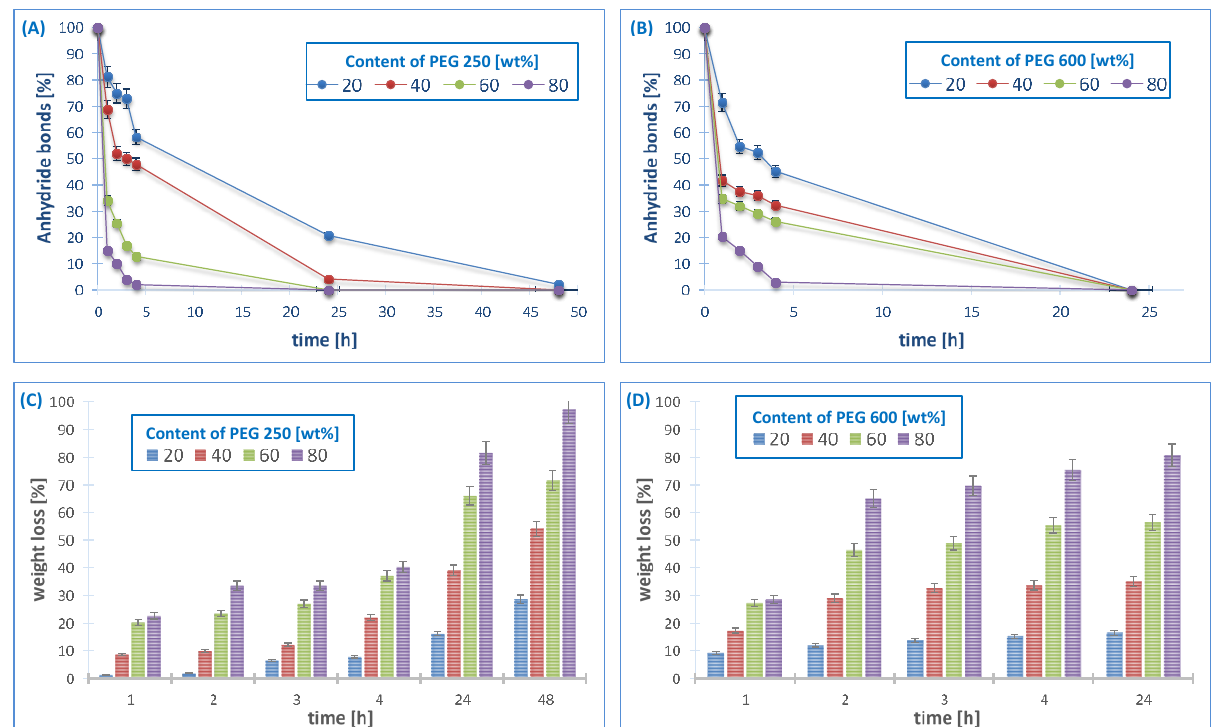
Figure 4. Anhydride bonds loss and weight loss of copolymers based on PEG 250 ( A , C ) and PEG 600 ( B , D ) during hydrolytic degradation in phosphate buffer conducted at 37 °C ( n = 3, error bars, standard deviation).